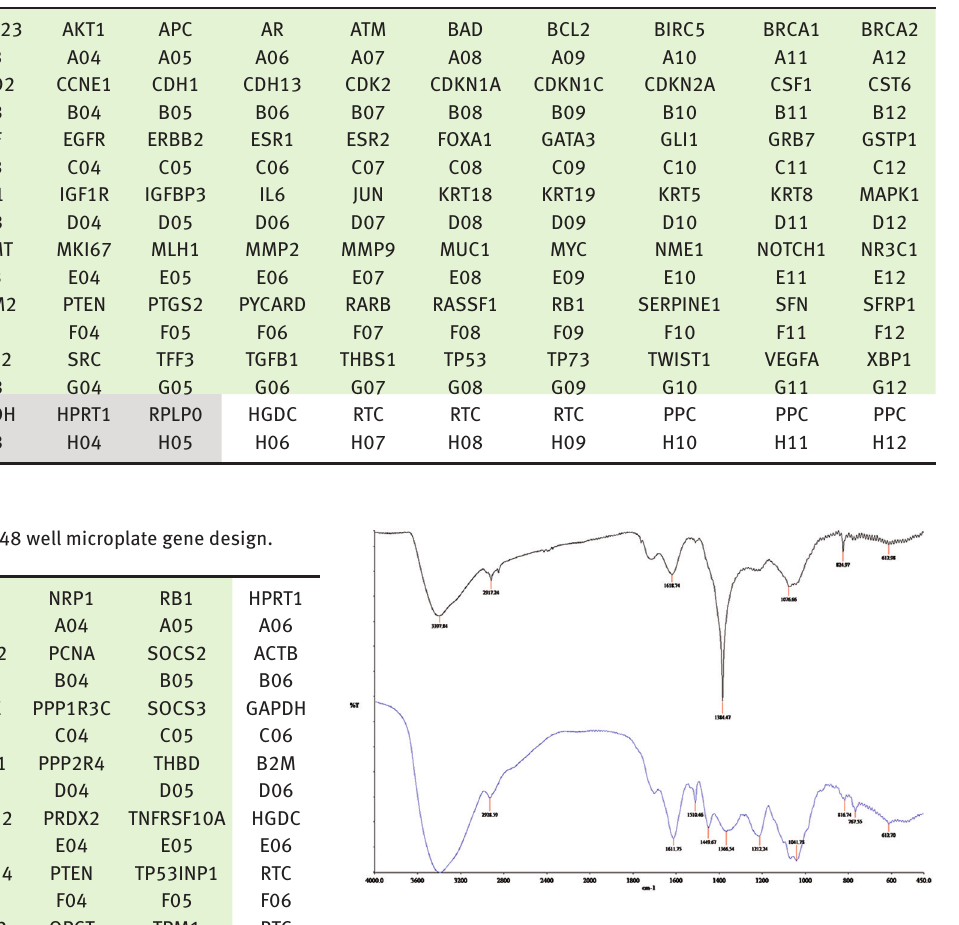
Table 2: “PCR Array Human Breast Cancer” 96-well microplate gene design.